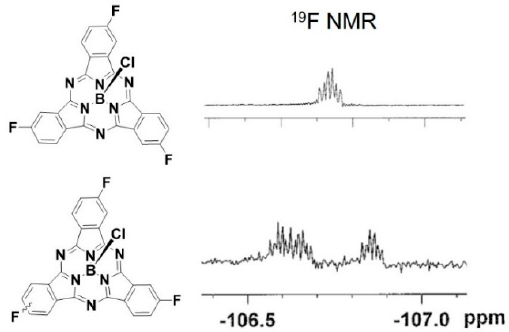
Figure 2. 19 F NMR of F 3 SPc(C 3 ) ( upper ) and F 3 SPc(C 1 ) ( lower ).